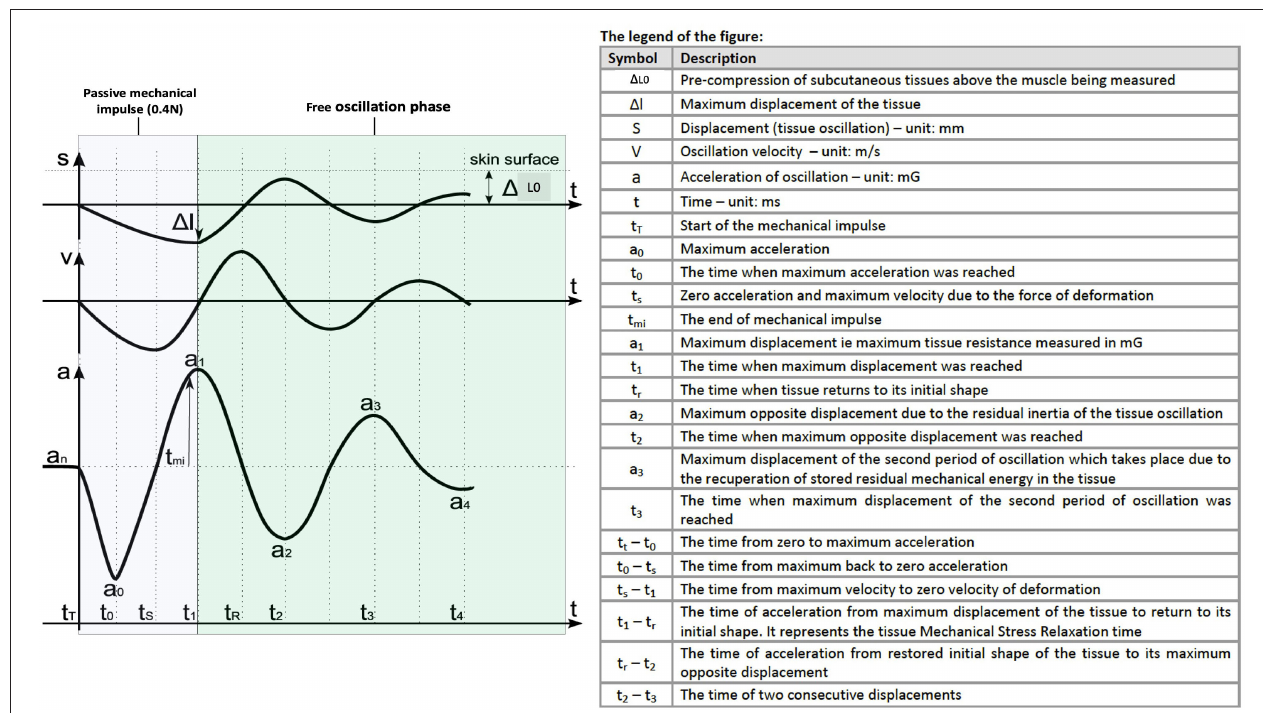
FIGURE 1 | Description of the induced mechanical impulse and the free oscillation phase and the relationship with displacement (l), velocity (V), and acceleration (a). Adapted from the MyotonPro user manual (MyotonPro AS, London, United Kingdom) and previously described by Schneider et al. (2015).